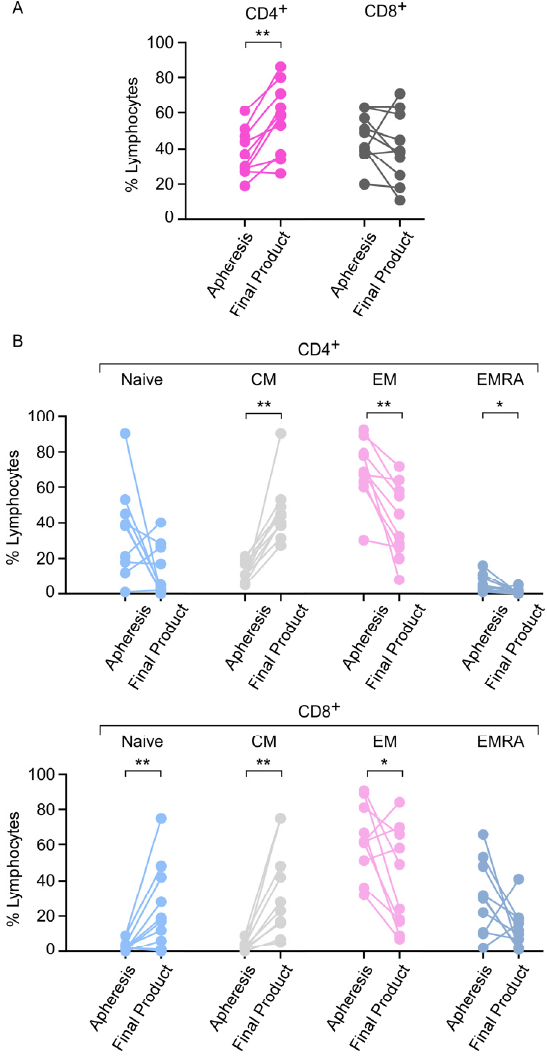
Figure 2. Percentages of the different T-cell subsets in the apheresis and commercial CAR T-cell products. ( A ) Percentages of CD4 and CD8 T lymphocytes in the apheresis and final products are presented for 10 patients. ( B ) The phenotypes (naive, central memory (CM), effector memory (EM), effector memory re-expressing CD45RA (EMRA)) of CD4 and CD8 T-cells in the apheresis and CAR T-cell products are presented. p -values were calculated using a Mann–Whitney test and significant values are shown (*, p -value between 0.02 and 0.05; **, p < 0.02).